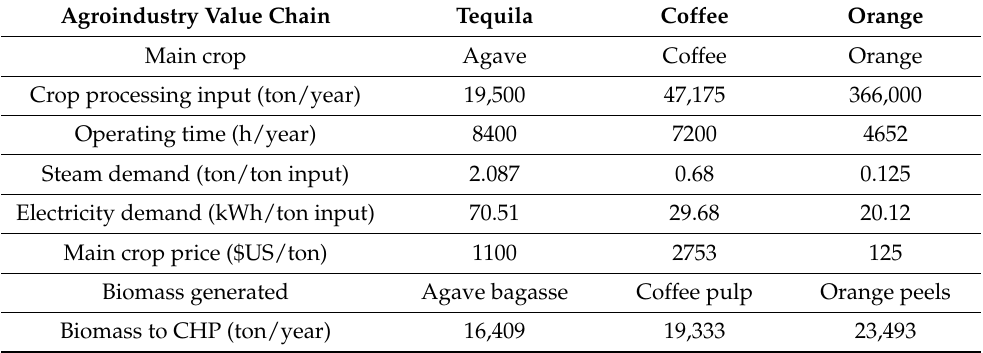
Table 2. Composition of agroindustrial biomass (agave bagasse, coffee pulp and orange peels).